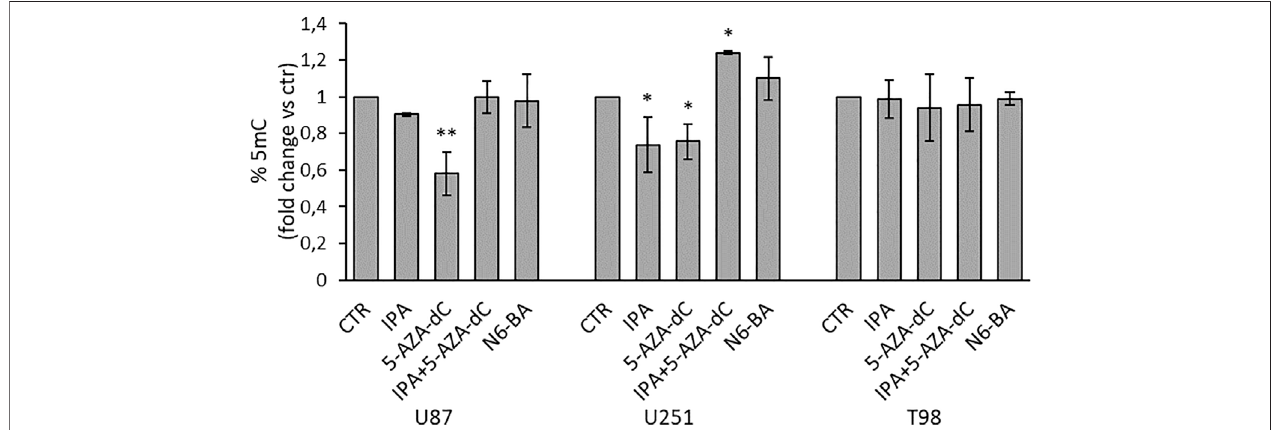
FIGURE6| Effect onglobalDNAmethylationinGBMcelllines. Quanti fi cation ofglobal DNA methylation (ELISA) performed using 100 ngofgenomicDNAisolated from GBM cells treated for 24 h with IPA (10 µM), 5-AZA-dC (500 µM), IPA+5-AZA-dC combination, or N6-BA (10 µM). DNA methylation (% 5-mC) was expressed as fold change vs. control. Data are expressed as the mean ± SD of three independent experiments. * p < 0.05; ** p < 0.01 vs. control.